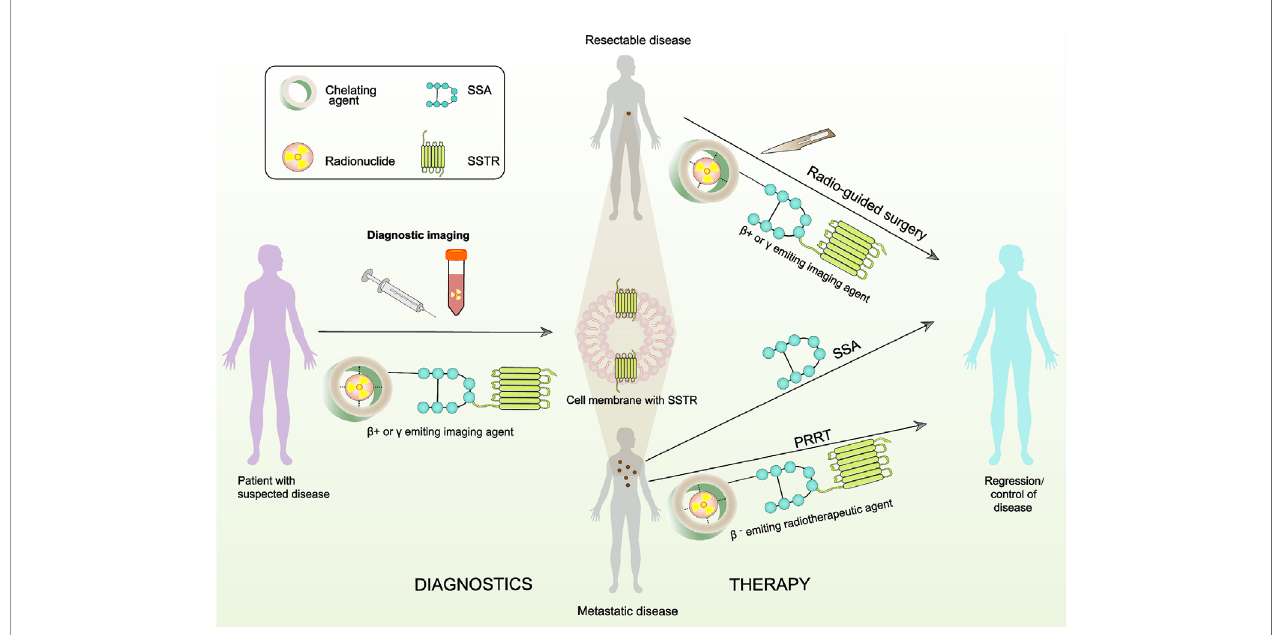
FIGURE 1 | A schematic presentation of theranostics with radiolabeled SSAs that target the SSTRs. The radiopharmaceutical element is comprised of the targeting fraction (SSA) and a chelator that forms a steady composite with the radionuclide. Radiotheranostics consists of diagnostic (panel on the left) and therapeutic (panel on the right)